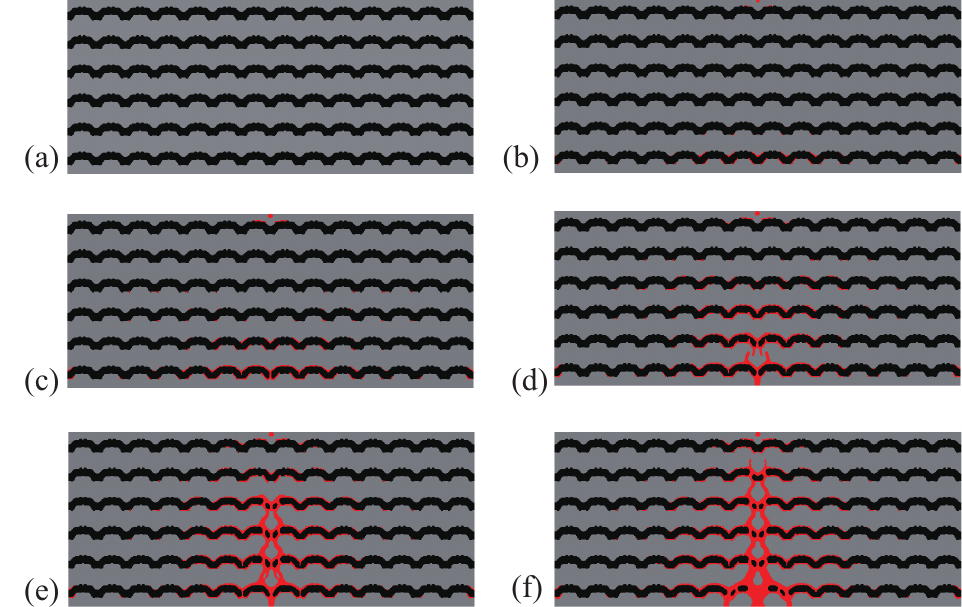
Figure 9. Crack propagation in the larger composite structure subjected to three-point bending, optimized design: ( a ) ¯ U = 0 mm; ( b ) ¯ U = 0.39 mm; ( c ) ¯ U = 0.52 mm; ( d ) ¯ U = 0.57 mm; ( e ) ¯ U = 0.61 mm; ( f ) ¯ U = 0.72